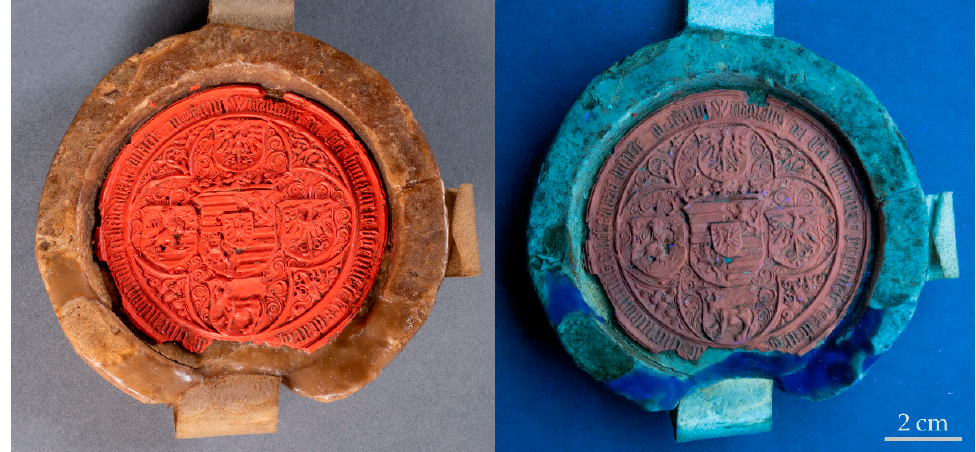
Figure 10. Seal of the charter CG-L 494 partially reconstructed using coloured Permulgin 3274. ( Left ): photograph acquired under visible light, ( Right ): photograph acquired under UV light (lamp: OSRAM L18 W/73). Photographs courtesy of the National archives in Prague.